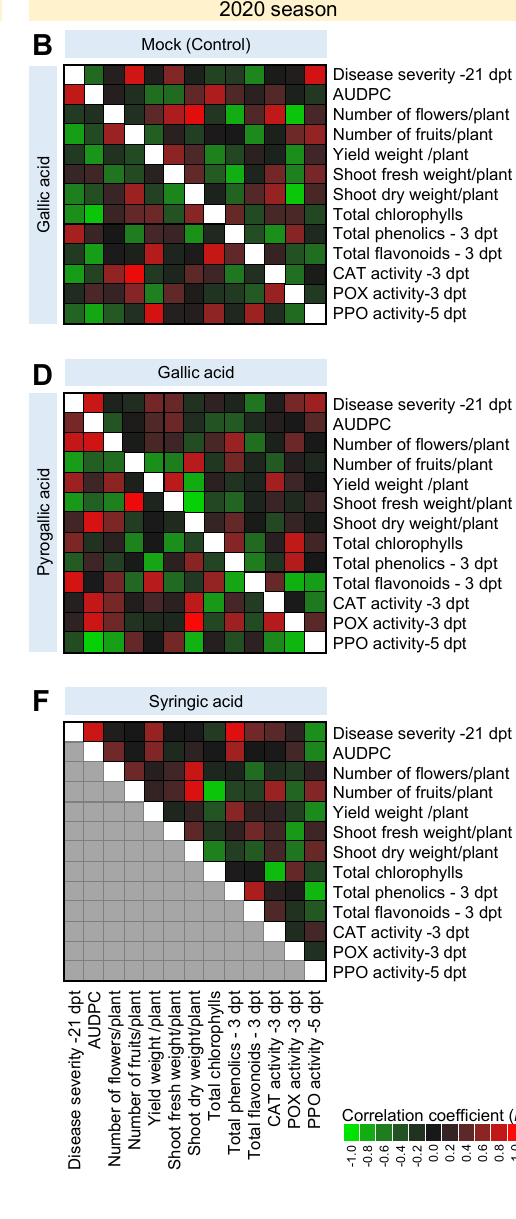
Figure 8. Correlation analysis between individual response variables assessed in A. solani -infected tomato plants (Super strain B–F 1 hybrid) under greenhouse conditions during 2019 and 2020 seasons. ( A , B ) Mock control and gallic acid and ( C , D ) pyrogallic acid and syringic acid ( E , F ).